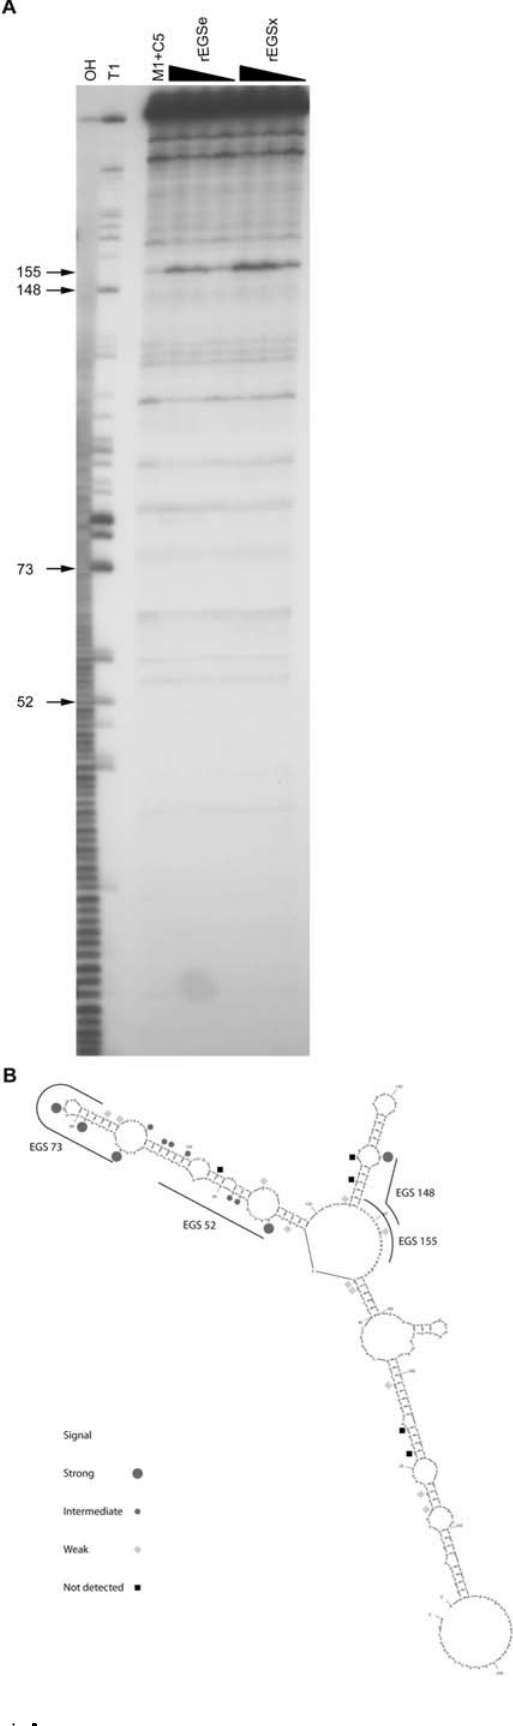
Figure 1. Mapping of accessible sites in the target mglB mRNA by RNase T1 and rEGS libraries. A. Polyacrylamide gel electropho- resis of cleavage products of 5 9 end labeled mglB mRNA generated by RNase P holoenzyme and rEGSe or rEGSx libraries. The RNase P holoenzyme was reconstituted by 10 nM M1 RNA and 100 nM C5 protein. mglB mRNA cleavage products were separated on 8% polyacrylamide/7 M urea gels together with an alkali ladder and a partial RNase T1 digest of the same RNA. Arrows indicate positions selected for further analyses. The black filled triangles represent decreasing concentrations of rEGSs (1000-, 100-, and 10-fold molar excess to the mglB mRNA) incubated with RNase P holoenzyme. Lane OH represents the alkali ladder. Lanes T1 and M1 + C5 represent reaction with RNase T1 and RNase P holoenzyme, respectively. The difference between rEGSe and rEGSx is the length of 3 9 end of rEGS mRNA resulted from the Bst NI digestion of the DNA fragments for in vitro transcription. The numbers indicate the positions of cleavage relative to the mglB translational initiation site. B. Complexes between the mglB mRNA and EGS52, EGS73, EGS148, and EGS155. The secondary structure of the partial mglB sequence used for the assay was created by the Mfold program [21]. Signal strength is according to the RNase T1